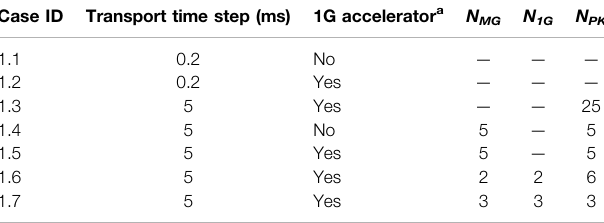
TABLE 1 | PCQM options for the cases in Problem 1.